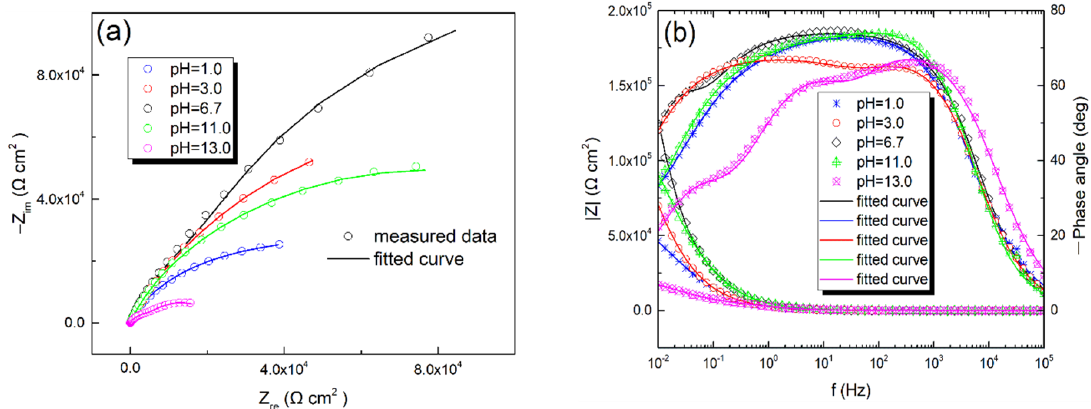
Figure 7. Typical EIS ( a ) Nyquist diagram, and ( b ) Bode diagram for galena in NaCl solution of different pH values. Table 4. Fitted impedance parameters for galena in NaCl solutions with different pH values.